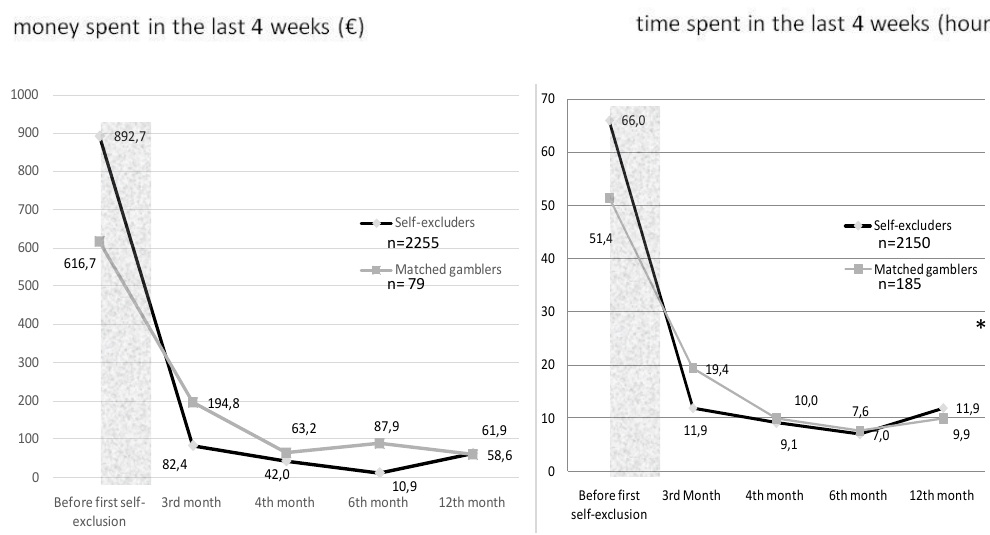
Figure 2. Evolution of money spent (net loss) in the last 4 weeks before and after the self-exclusion period among the gamblers who were the most heavily involved in terms of money ( n = 2255 and 79 respectively for the self-excluders and the control group of matched gamblers) and time ( n = 2150 and 185 respectively for the self-excluders and the control group of matched gamblers) (* = p-value < 0.05 - ANOVA between the mixed model with and the null model without the interaction of self-exclusion X time).